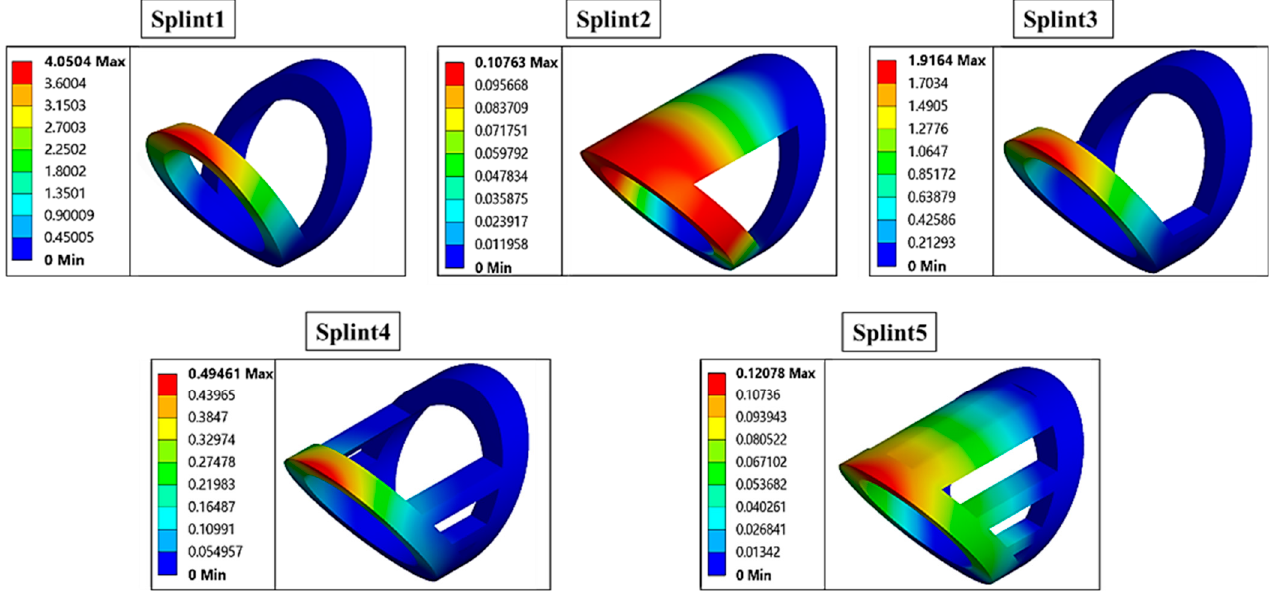
Figure 8. Deformation results of different splint models at 0.64 MPa pressure .